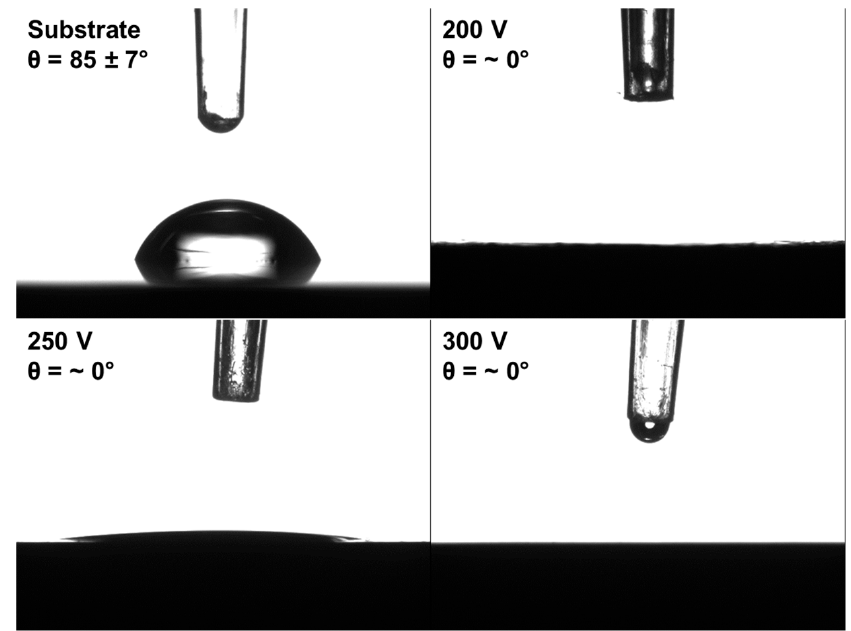
Figure 6. Droplet shapes and contact angles. Table 2. Physical characteristics of the PEO